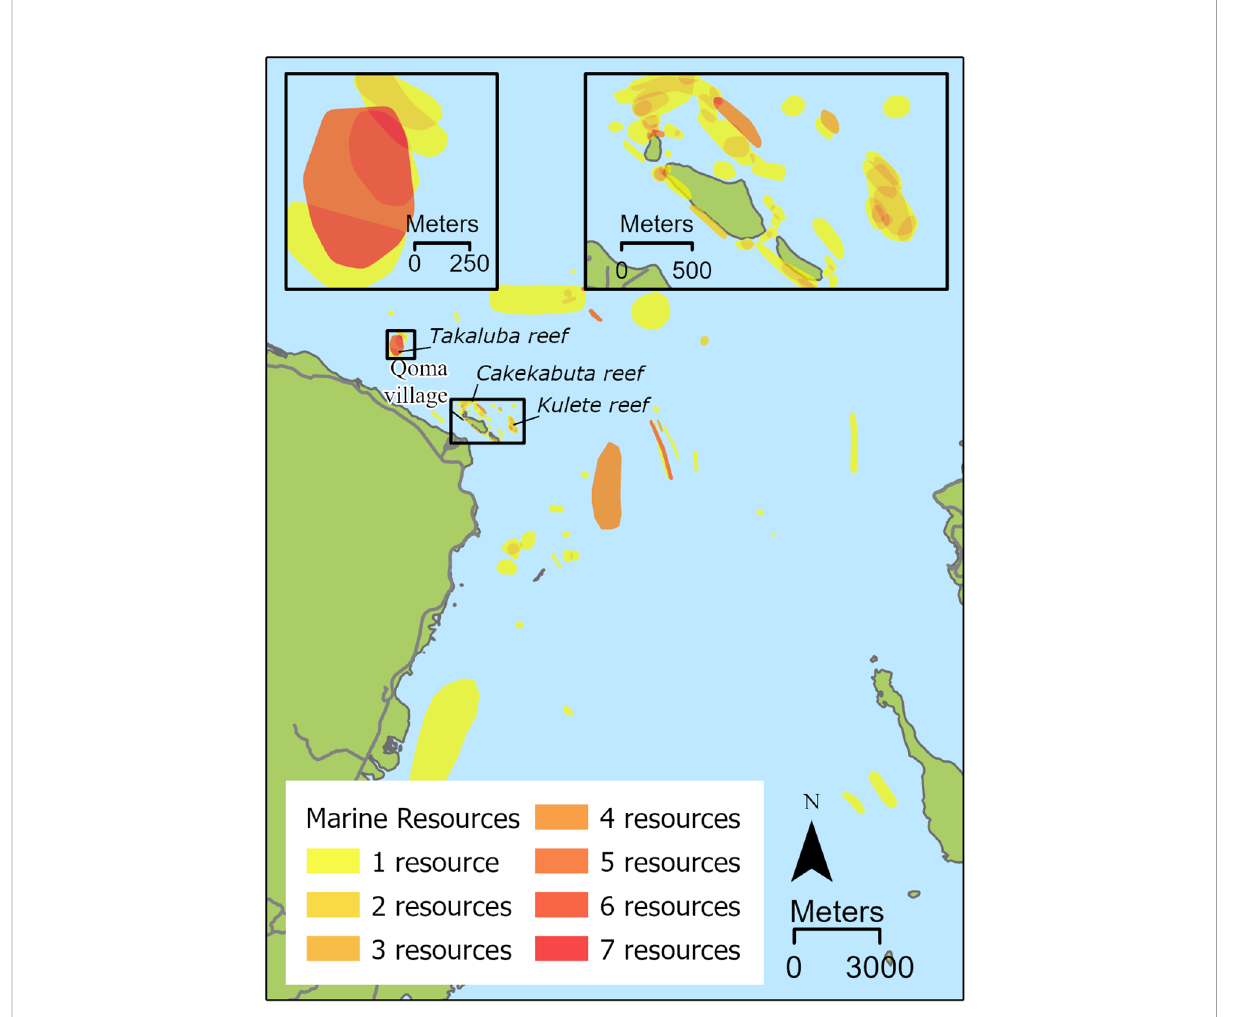
FIGURE 6 Spatial overlap of marine resources showing relatively high resource richness of Takaluba reef and the north end of Nabulebulewa island fringing